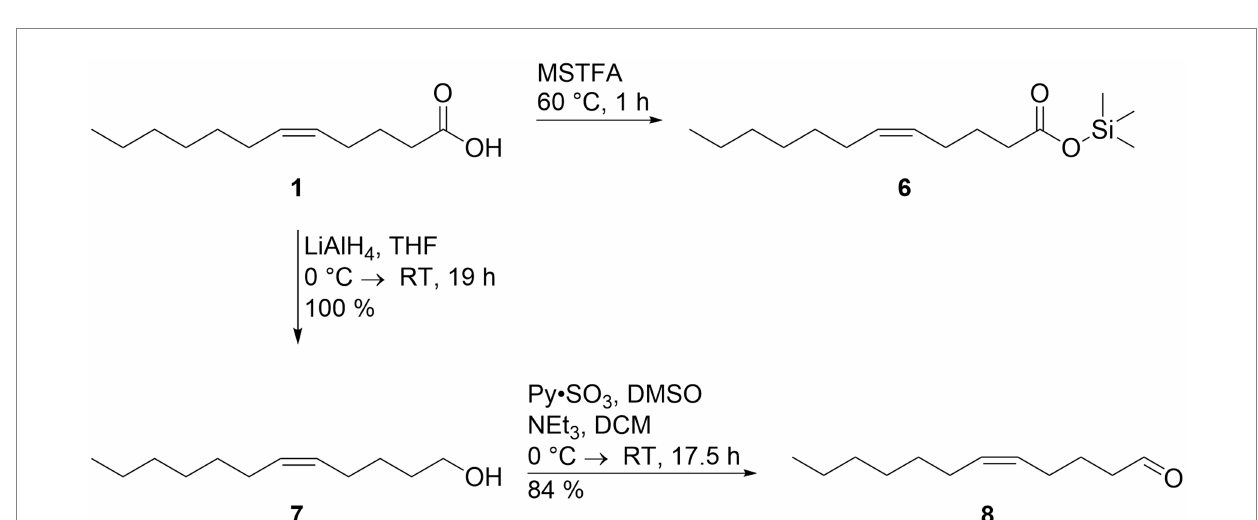
FIGURE 3 Syntheses of reference compounds trimethylsilyl ( Z )-5-dodecenoate ( 6 ) and ( Z )-5-dodecenal ( 8 ). The synthesis is described in detail in the text. The trimethylsilyl ester of natural compound A proved to be identical to compound 6 , confirming the identity of ( Z )-5-dodecenoic acid ( 1 ), and natural compound B .